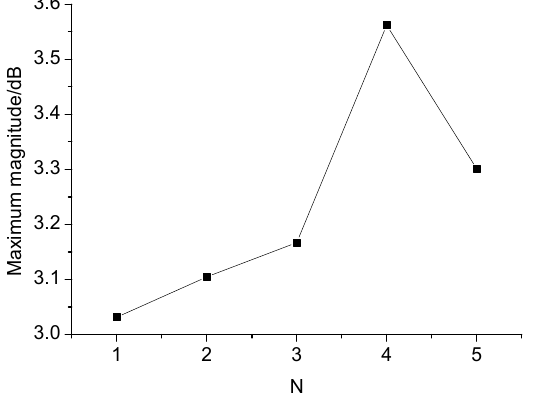
Figure 12. Maximum magnitudes of coal specimen at failure predicted by different loading-unloading cycles.